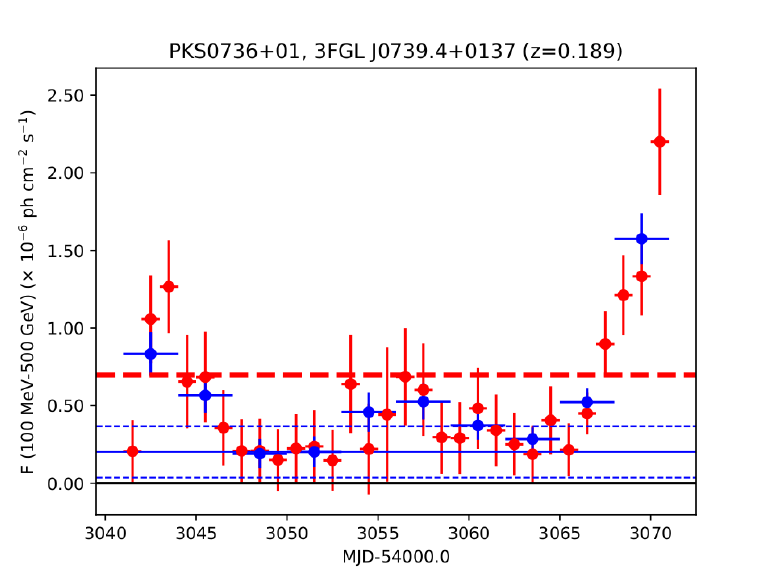
Figure 4. One month segment of the Fermi -LAT light curve from PKS0736 + 01 from FLaapLUC . H.E.S.S. observations were triggered and observations begun following the last measurement. The blue points show the data with bins of three days, while the red points represent the daily-binned data set. The solid blue line shows the long-term (10 years) flux average with 1 σ fluctuations (dashed blue lines), and the dashed red line shows the flux alert threshold for this